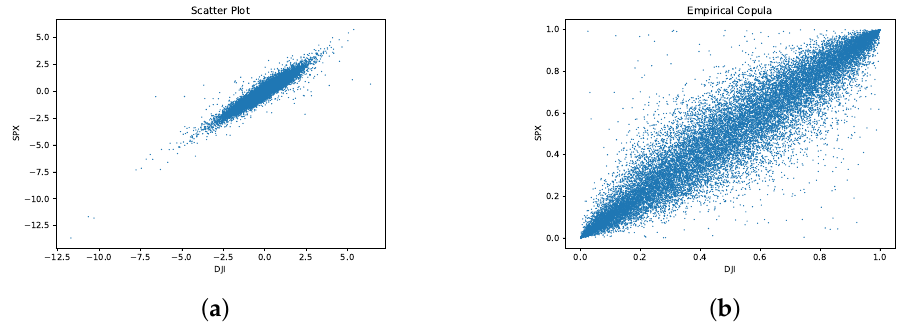
Figure 1. ( a ) Scatter plot and ( b ) empirical copula plot for SPX-DJI innovation pairs.